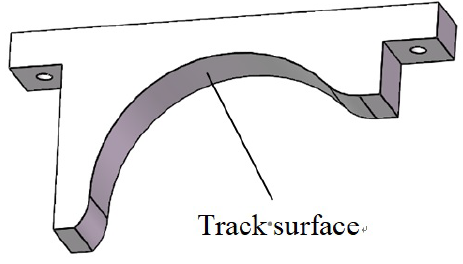
Figure 12. Track Figure 12. Track structure.